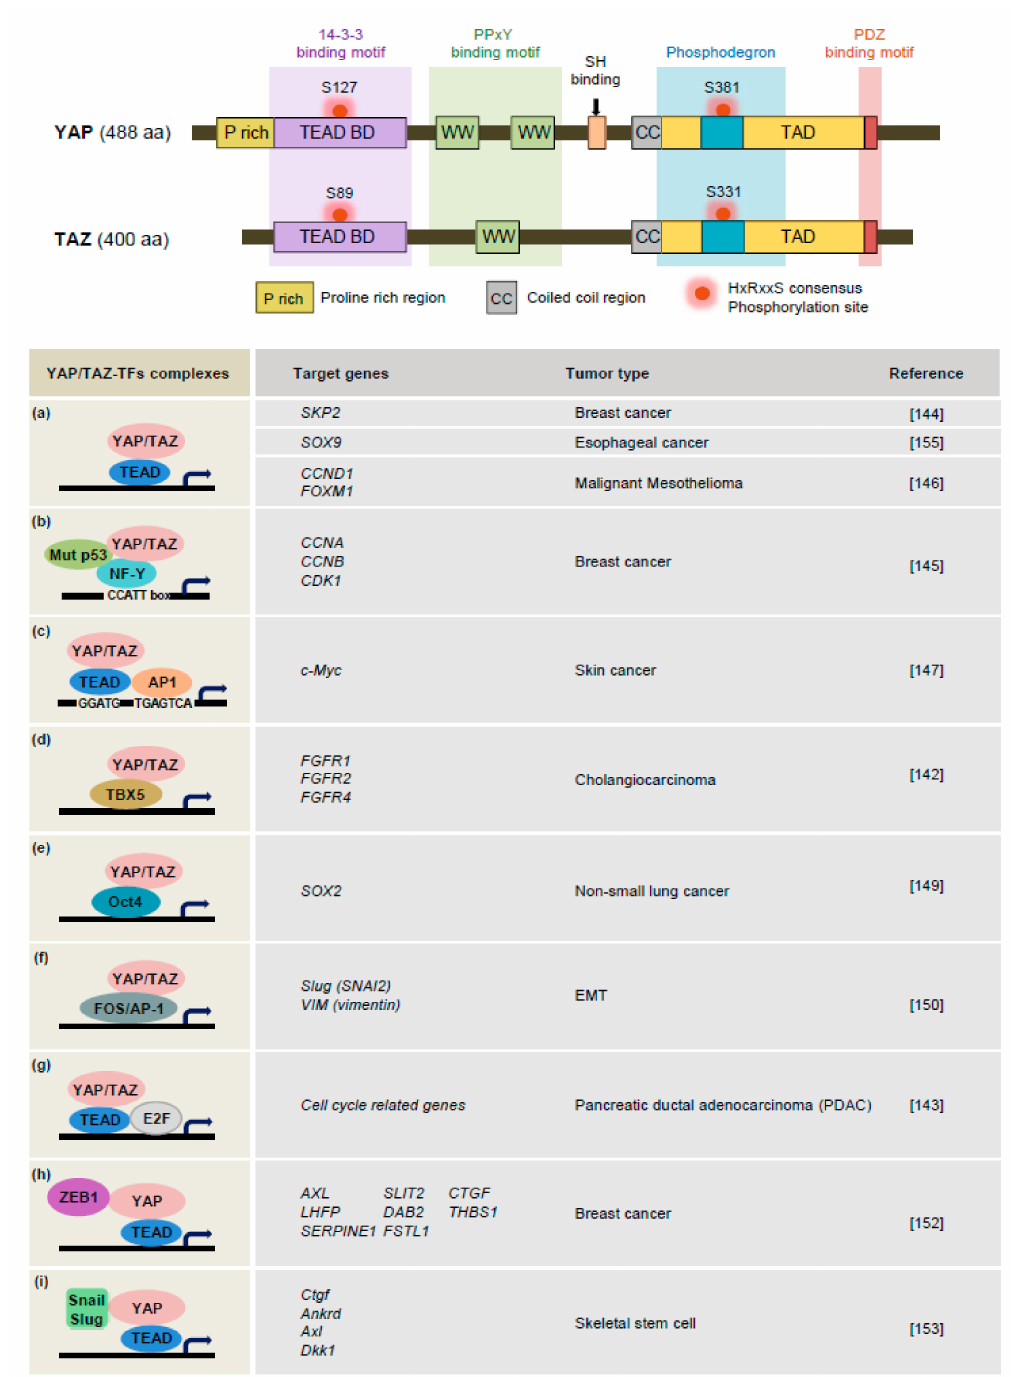
Figure 4. YAP / TAZ-mediated regulatory networks in cancer. YAP / TAZ are the major downstream mediators of the Hippo pathway and are composed of several domains (see Figure 1). The nuclear YAP / TAZ interacts with multiple transcription factors and signaling pathway that collectively contribute to